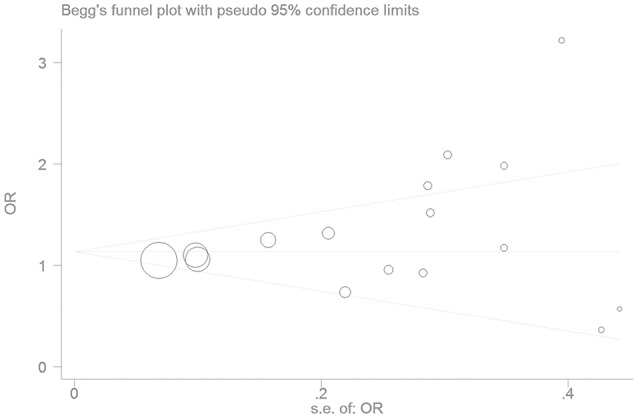
The Begg's funnel plot for the association of EH with ADRB3 gene Trp64Arg polymorphism under an additive genetic model (A vs. T). The horizontal and vertical axis correspond to the OR and confidence limits. OR, odds ratio.